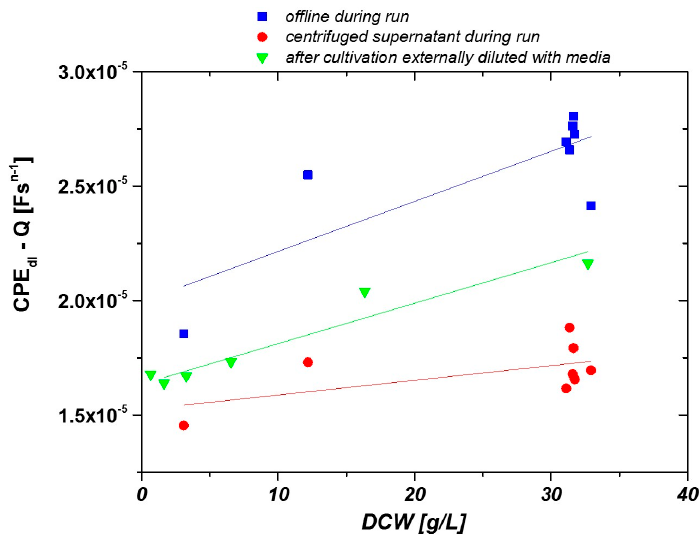
Figure 3. Offline measurements of clarified fermentation supernatant ( red circles), cultivation broth ( blue squares) and harvested cells resuspended in buffer at different concentrations ( green triangles).